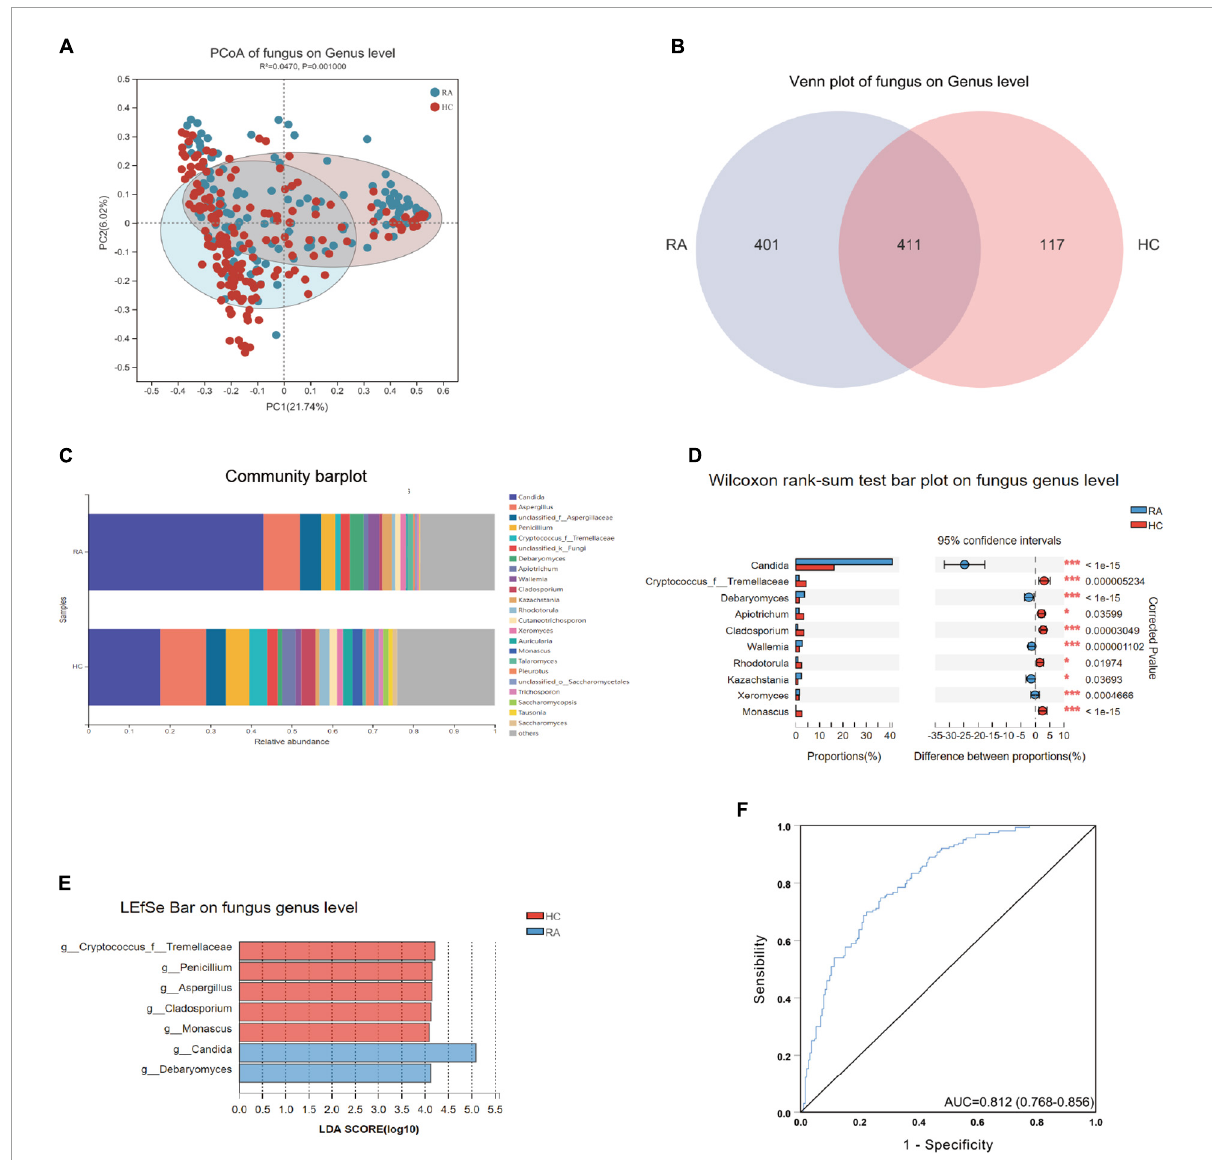
FIGURE5 The differential fungal flora and predicted enzymes based on ITS (on genus level) between RA and HC. (A) The Venn plot between RA and HC groups. (B) The PCoA analysis between RA and HC groups. (C) The Bar graph of fungal flora composition in RA and HC groups. (D) The top 10 significant fungal between RA and HC groups. (E) The LDA bar of fungal flora in RA and HC groups. (F) The ROC curve of the combination of seven differential fungal for classifying RA patients from HC. RA, rheumatoid arthritis; HC, healthy control; ROC, receiver operating